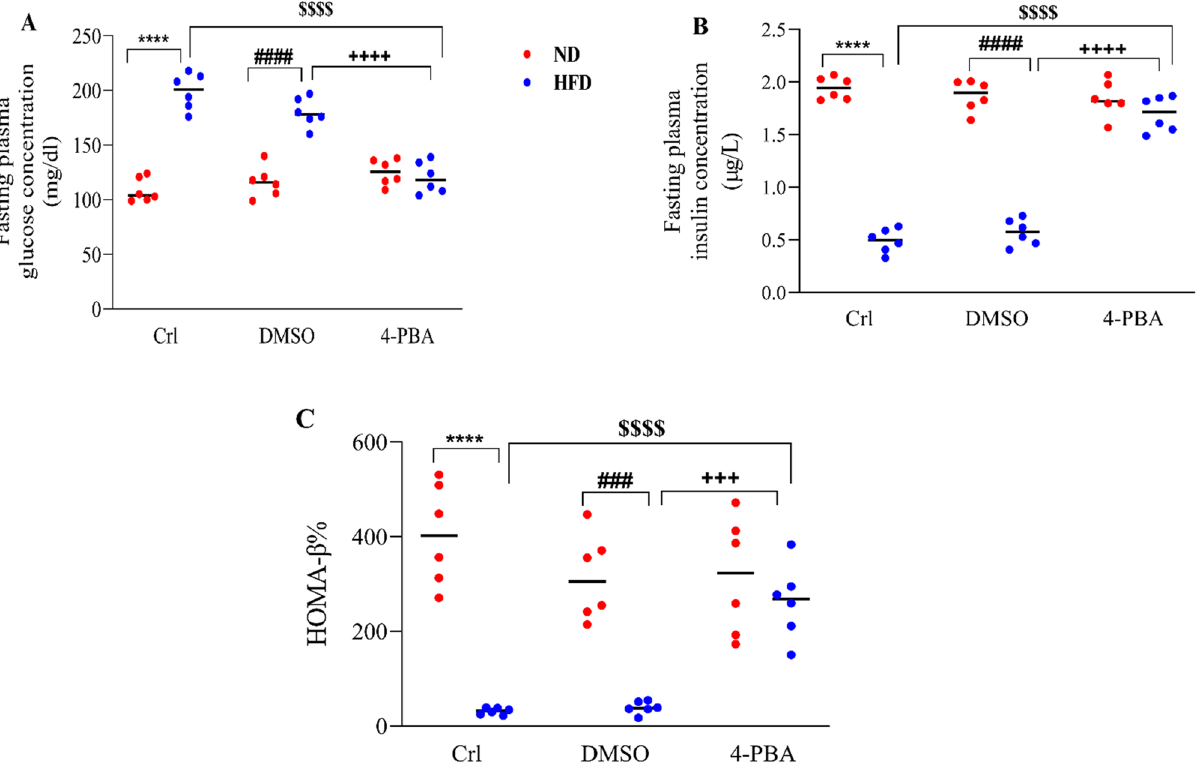
Figure 6. Effect of high-fat diet and/or 4-PBA on fasting plasma ( A ) glucose and ( B ) insulin levels and ( C ) HOMA-β%. Each point represents the mean ± SEM (6 rats/group). ****p < 0.0001 versus control of ND group, ### p < 0.001, #### p < 0.0001 versus ND + DMSO group, $$$$ p < 0.0001 versus control of HFD group, +++ p < 0.001, ++++ p < 0.0001 versus HFD + DMSO group. ND Normal diet, HFD High-fat diet, Crl Control, DMSO Dimethyl Sulfoxide, 4-PBA 4-Phenyl Butyric